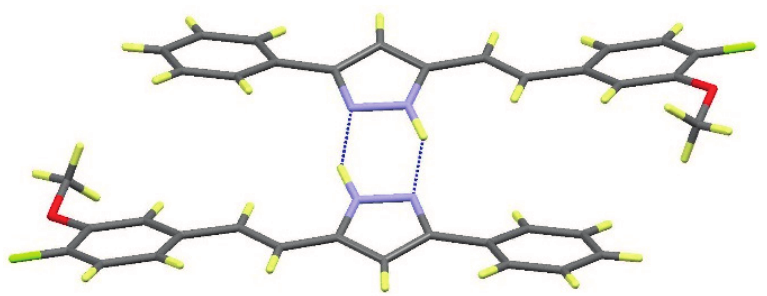
Figure 6. View of the dimer in 16